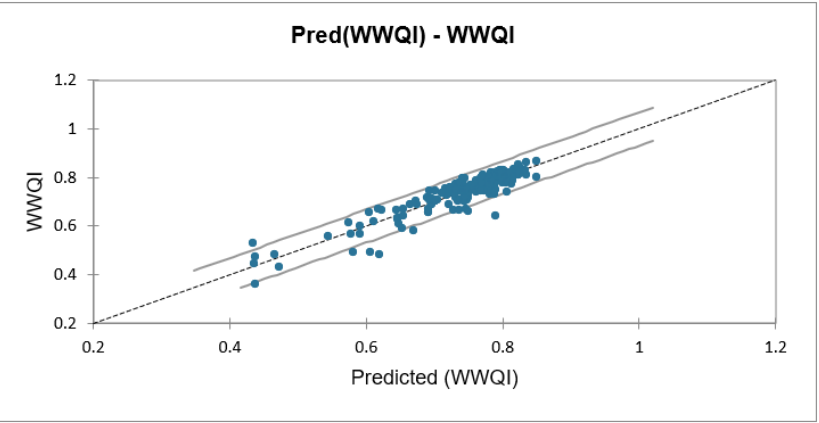
Figure 6. Comparison between predicted and observed values for the WWQI by XLSTAT model.